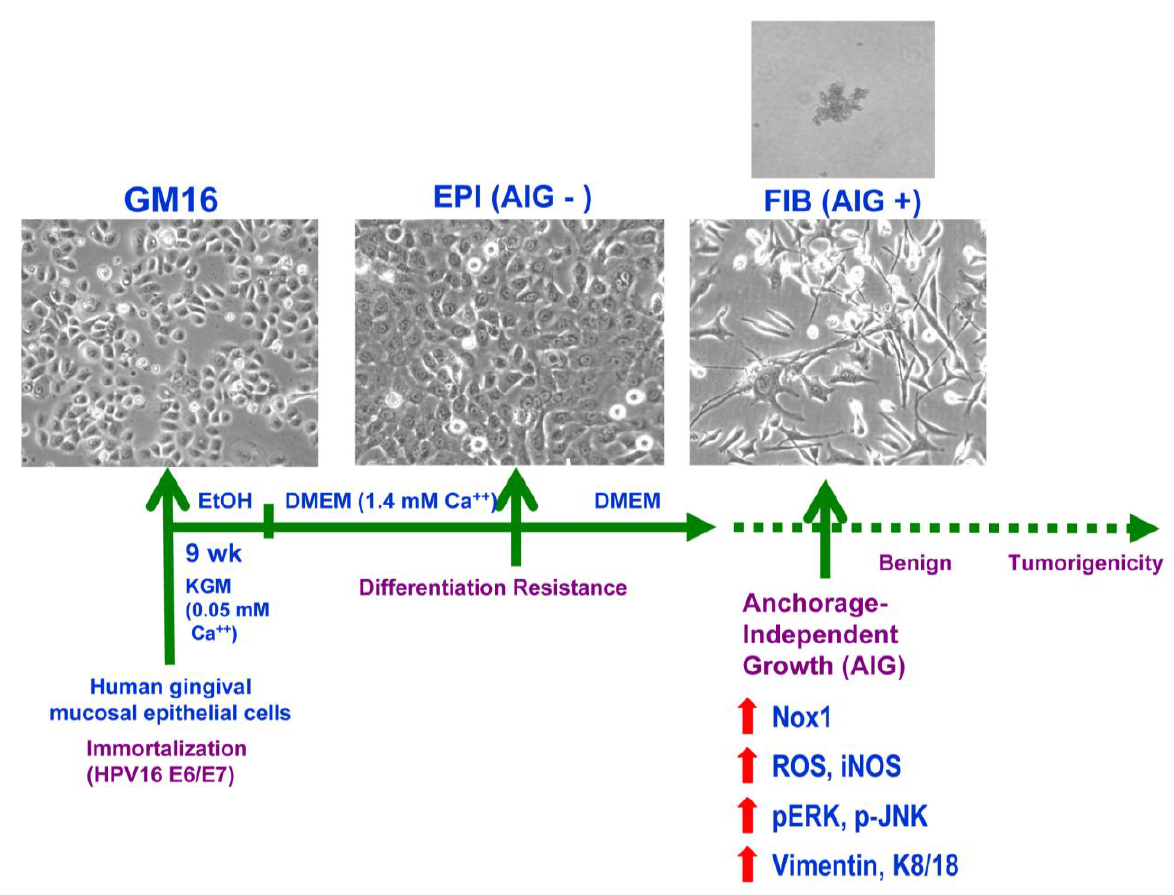
FIGURE 2. An experimental design to determine an association of Nox1 on cell transformation induced by ethanol stress. Immortalized human gingival mucosal keratinocytes (GM16) were exposed to ethanol for 9 weeks, followed by exposure in high calcium in DMEM. Differentiation-resistant cells were resultant preneoplastic cells; EPI and FIB cell lines. FIB cells were capable of growing anchorage independently, thus being more transformed than EPI cells. FIB cells expressed increased Nox1, ROS, and iNOS (inducible nitric oxide synthase) concomitant with an activation of ERK and JNK. Concerning cytoskeletal changes, FIB cells expressed vimentin and simple/fetal epithelial keratins